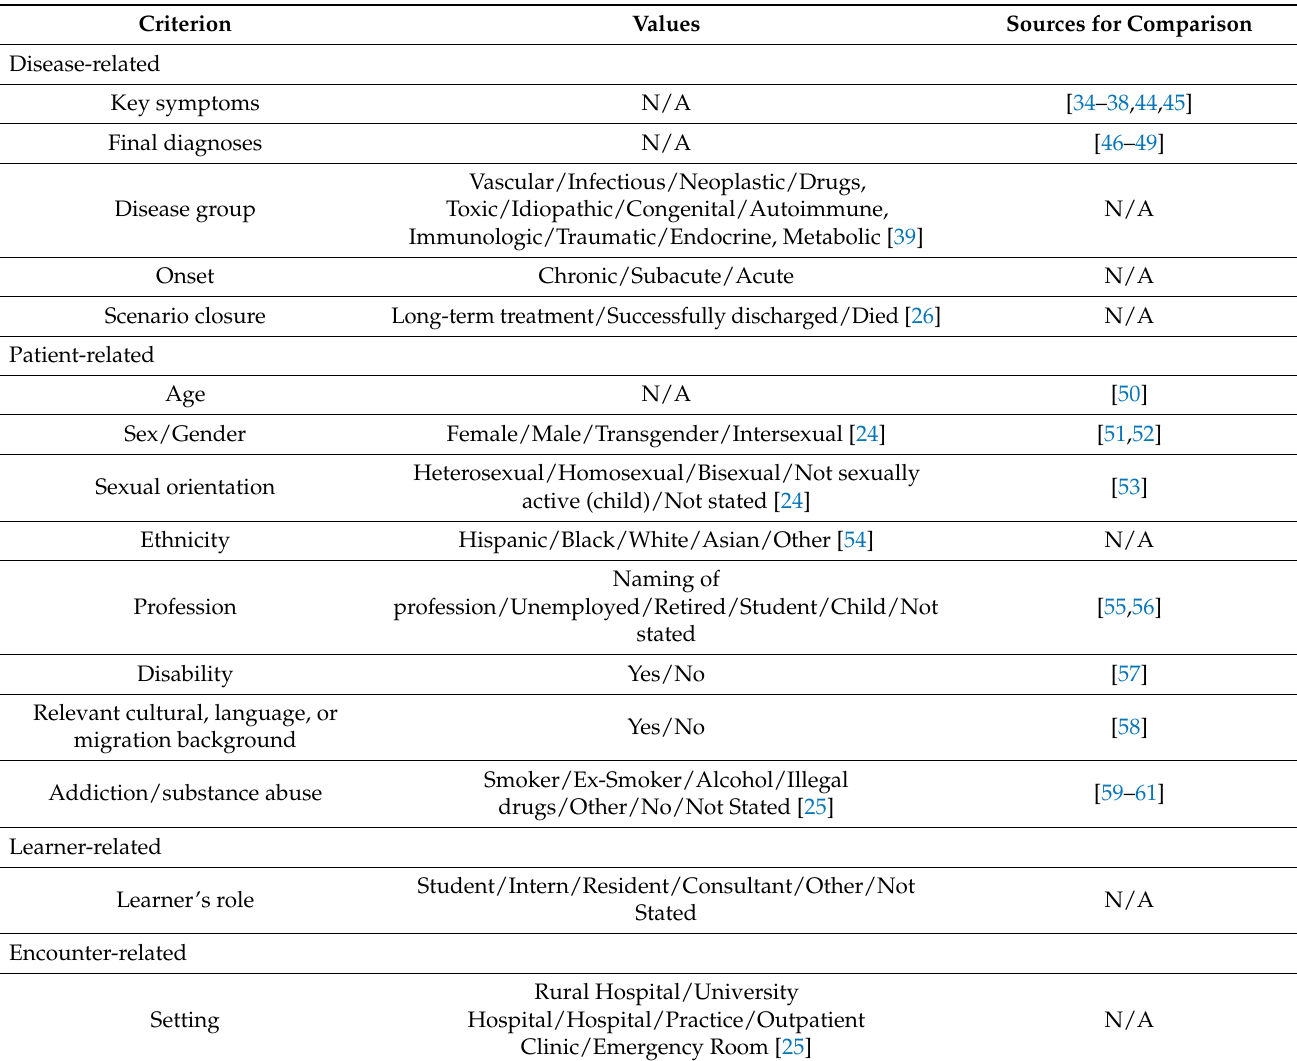
Table 1. Overview of criteria, permitted values, and sources for